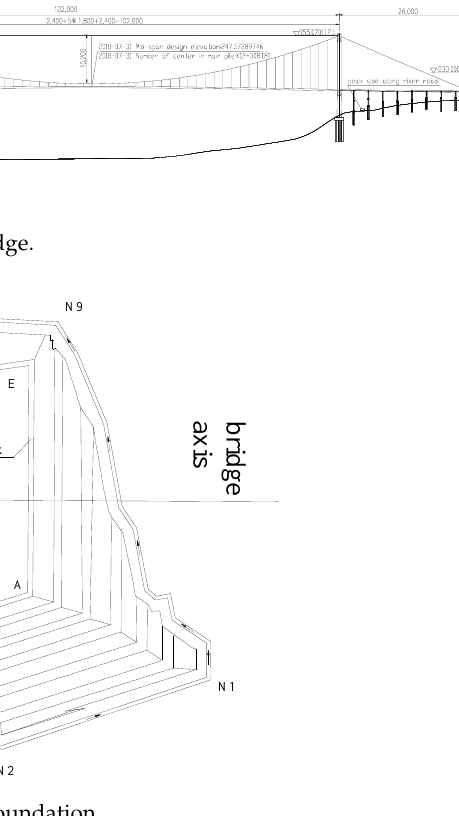
Figure 3. The plan of the anchorage foundation.